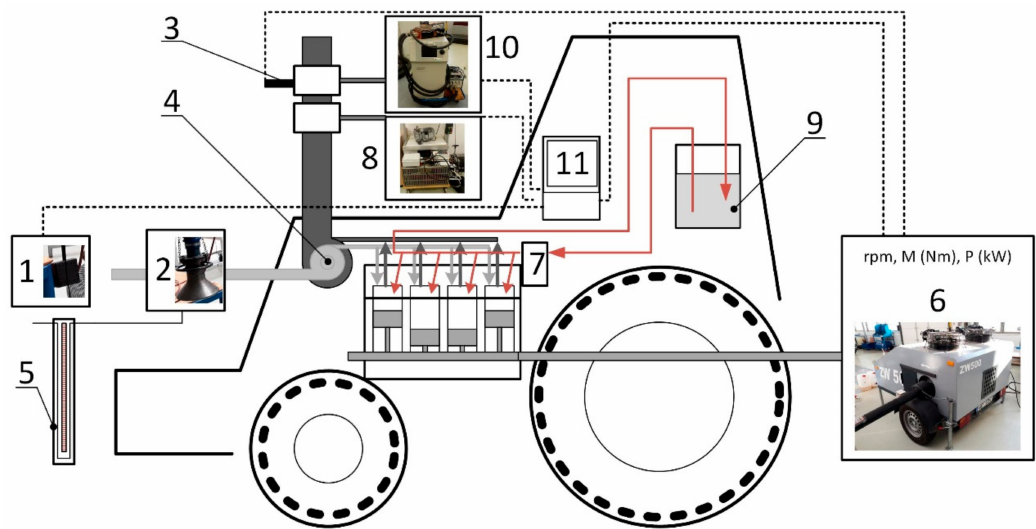
Figure 4. Measurement scheme: 1—sensors for pressure and temperature of the intake air, 2—lossless nozzle, 3—exhaust gas temperature sensor, 4—turbocharger, 5—U-tube manometer, 6—dynamometer, 7—fuel pump, 8—emission analyzer, 9—fuel tank, 10—EEPS, 11—PC for control and data